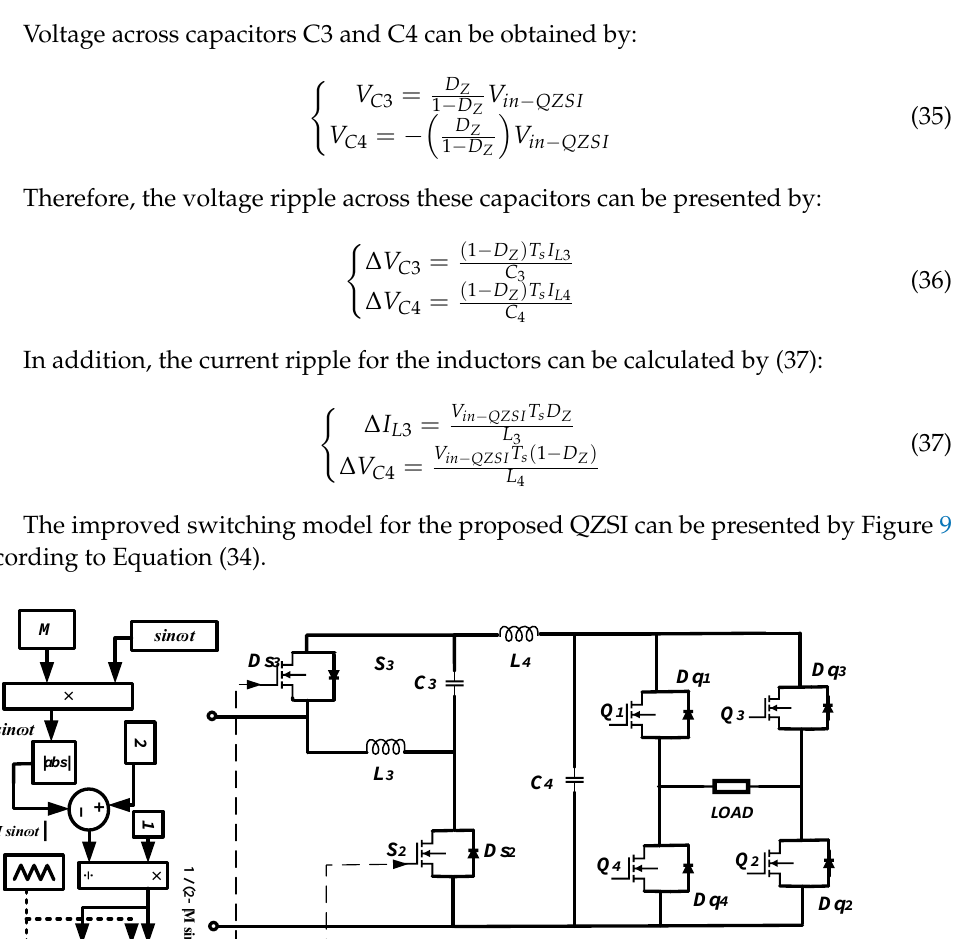
Figure 8. Voltage states across the capacitors of the QZSI and drain-source pins of the FBI switches. Voltage across capacitors C3 and C4 can be obtained by: